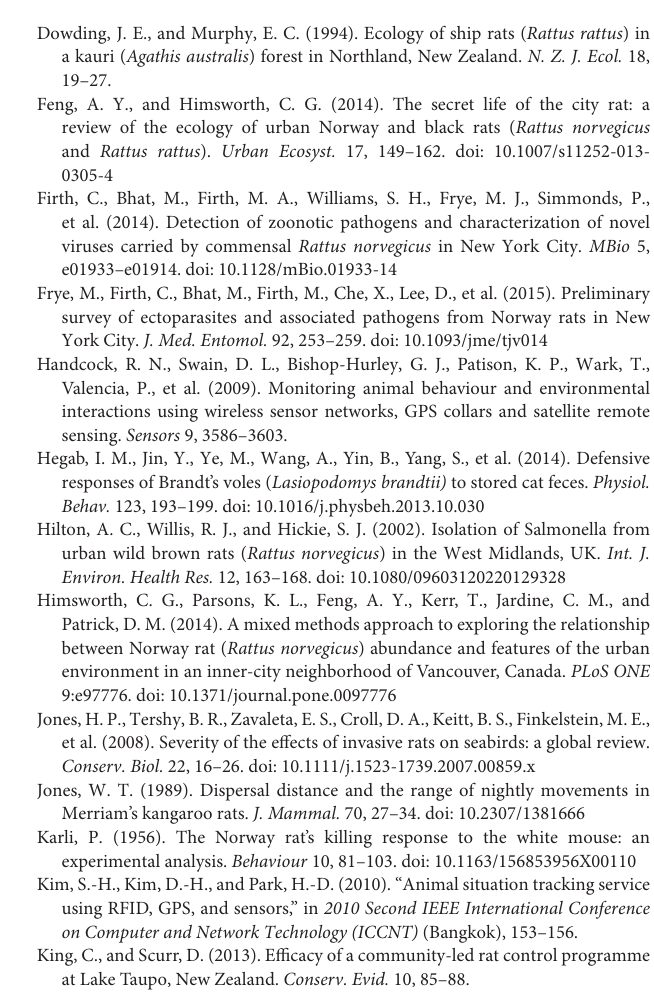
Figure S1 | Density plot of recruitment by hour to RFID antenna for wild Norway rats, Rattus norvegicus , captured on Eastern Long Island and monitored from January 14–May 15. Each point represents an individual visit. Figure S2 | Potential experimental design demonstrating the utility of using RFID technology with wild rodent populations to determine the efficacy of repellents or attractants for up to 5 colonies of rats, separated by at least 100m. Filled circle represents main colony entrance open circles represents bolt (escape)